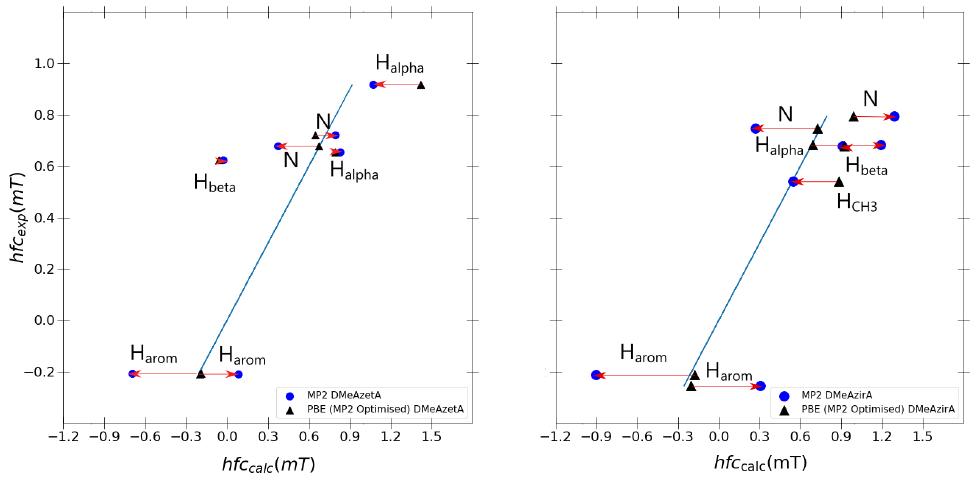
Figure 7. Individual PBE0 vs. MP2 hyperfine coupling constant comparisons for outlier molecules DMeAzetA and DMeAzira with MP2/6-31G(d,p) optimised geometries. Fitted blue line in each graph is the ideal fit line for calculated results given as y = x .